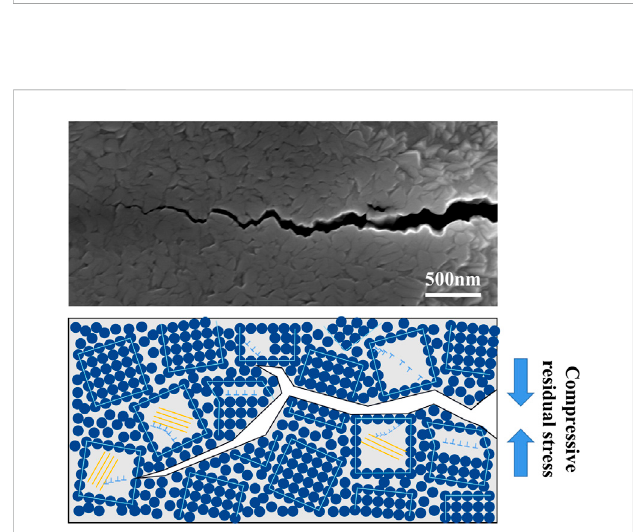
FIGURE 8 Magni fi cation image of crack and the schematic diagram of the toughening mechanism corresponding to the ZrNbTiMo RHEA fi lms deposited at 150